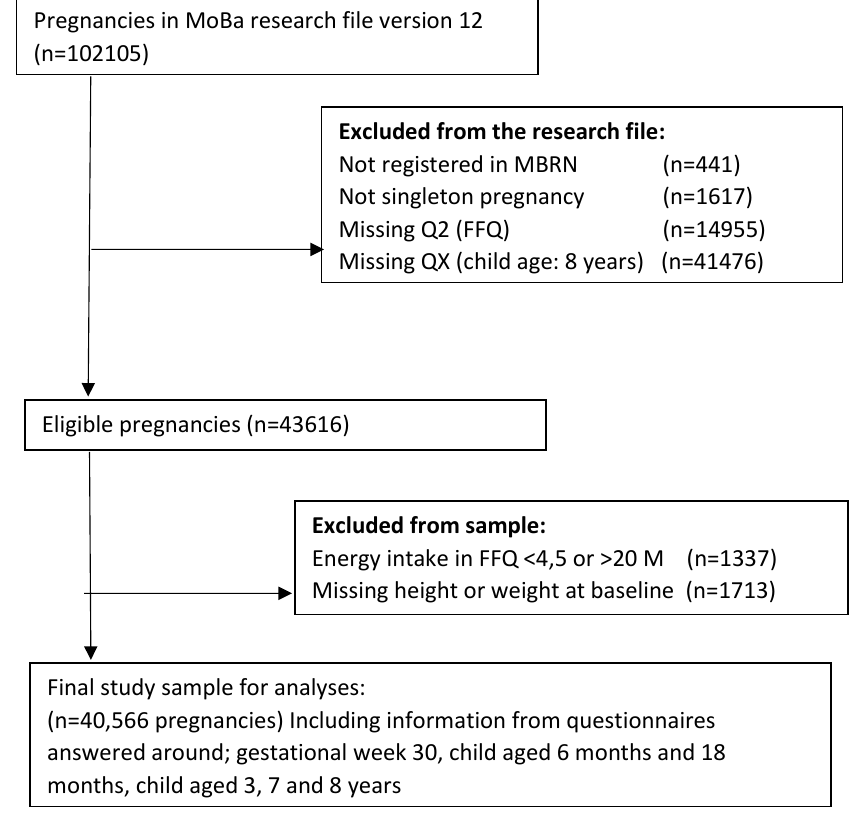
Figure 1. Flow chart inclusion of participants in the